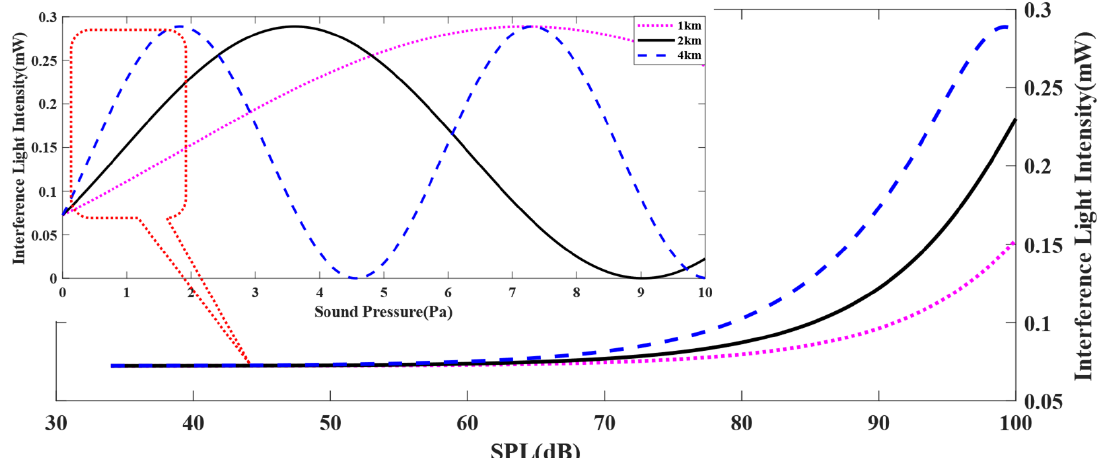
Figure 3. The influence of delay fiber length. When f = 5000 Hz and L 1 = 2 km, the SPL is between 50 and 100 dB, and the length of the sensing fiber is set to 10 m, 20 m, and 40 m, the influence of optic fiber acoustic pick-up to sound pressure and interference light intensity is shown in Figure 4. Similar to the effect of delay fiber, the longer the optic fiber acoustic pick-up is, the shorter period of interference light intensity and the higher sensitivity of photoacoustic detection are. As the length of optic fiber acoustic pick-up increases, the sound-pressure-detection range becomes narrower. When the sensing fiber length is 30 m, although the sensitivity is higher, the curve is close to the crest at 100 dB and the linearity of the response curve becomes poor. When the sensing fiber is 10 m, the sensitivity is lower. Considering the balance of sensitivity and detection range, 20 m sensing optic fiber is the best choice.